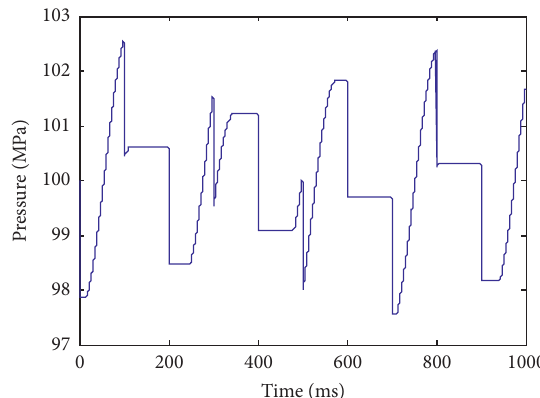
Figure 8: Changes in fuel pressure in high-pressure fuel line with only one fuel injector.